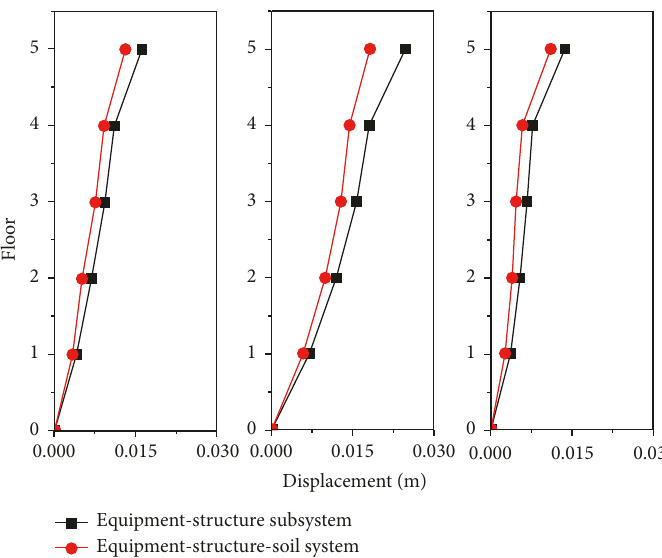
Figure 14: Peak displacement responses during the minor earthquake.